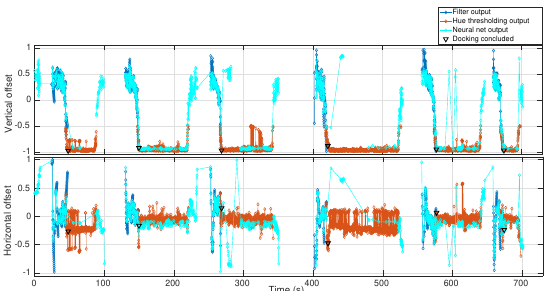
Figure 24. aMussel image offsets during the docking experiment in the field. Triangular markers denote where each separate docking attempt ended.